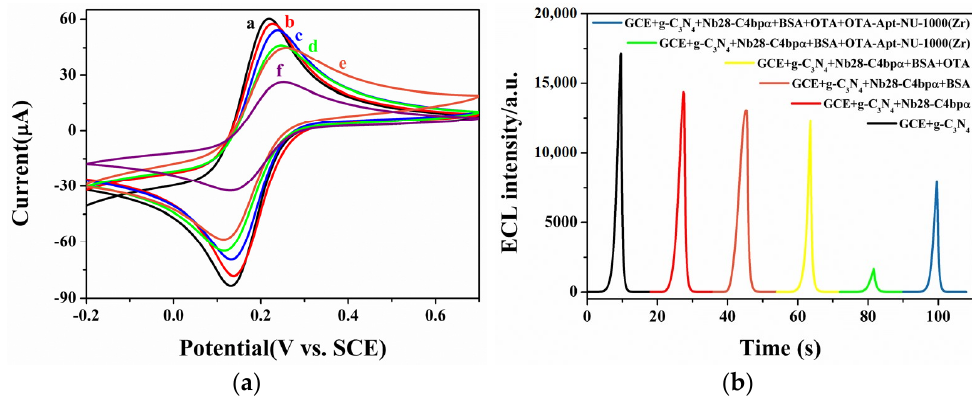
Figure 5. ( a ) CV curves of GCE(a), g − CN/GCE(b), Nb28 − C4bp α heptamer/g − CN/GCE(c), BSA/Nb28 − C4bp α heptamer/g − CN/GCE(d), OTA/BSA/Nb28 − C4bp α heptamer/g − CN/ GCE(e) and